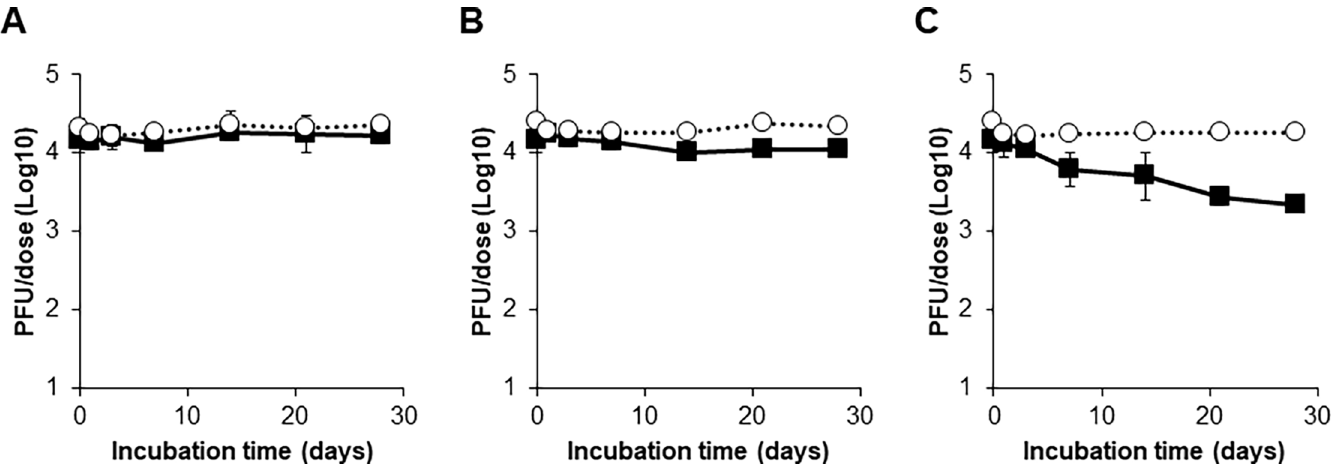
Fig 4. Stability testing of freeze-dried measles and rubella combination vaccines. After incubation of freeze-dried vaccines at 4˚C (A), 25˚C (B), or 35˚C (C), titres of measles and rubella viruses in the vaccines were measured by plaque assays. Filled squares and open circles indicate titres of measles and rubella viruses, respectively. Means of three vials are shown. Error bars indicate standard deviations.